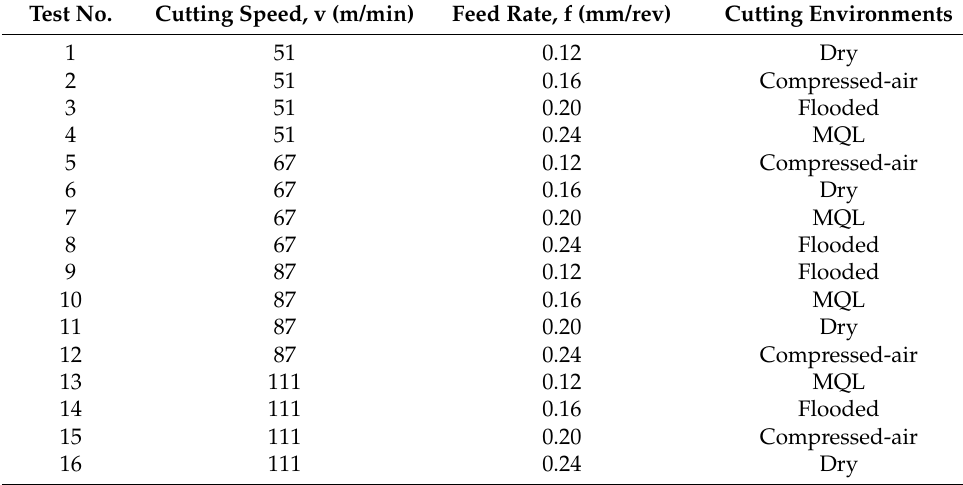
Table 2. Experimental design layout.